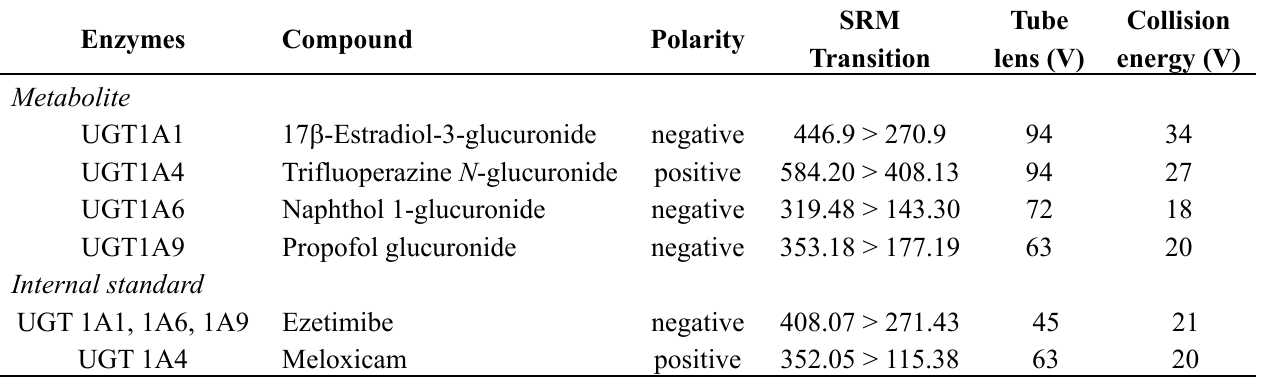
Table 2. LC/MS/MS measurement conditions for drug glucuronidation catalyzed by human UGT